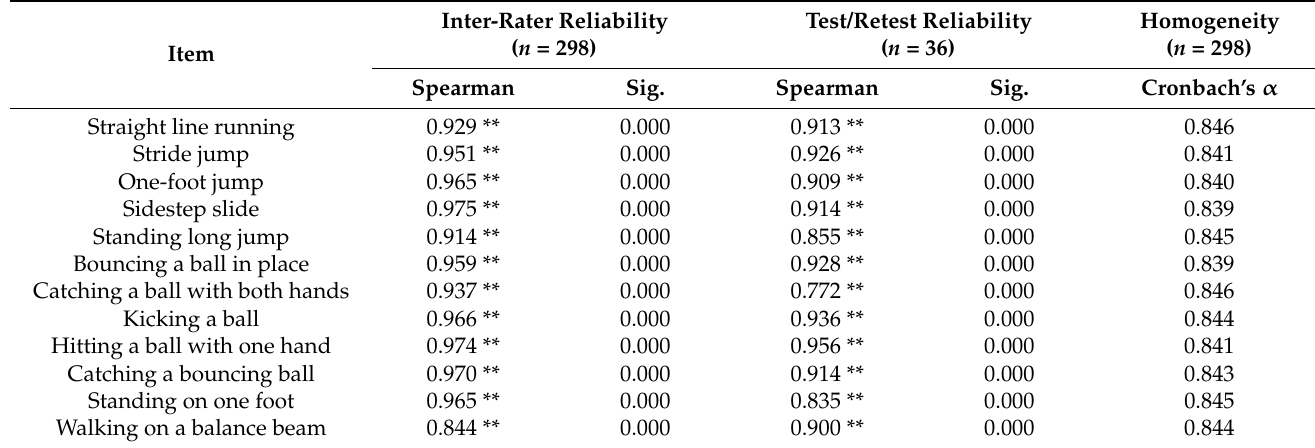
Table 6. Results of testing the final measurement